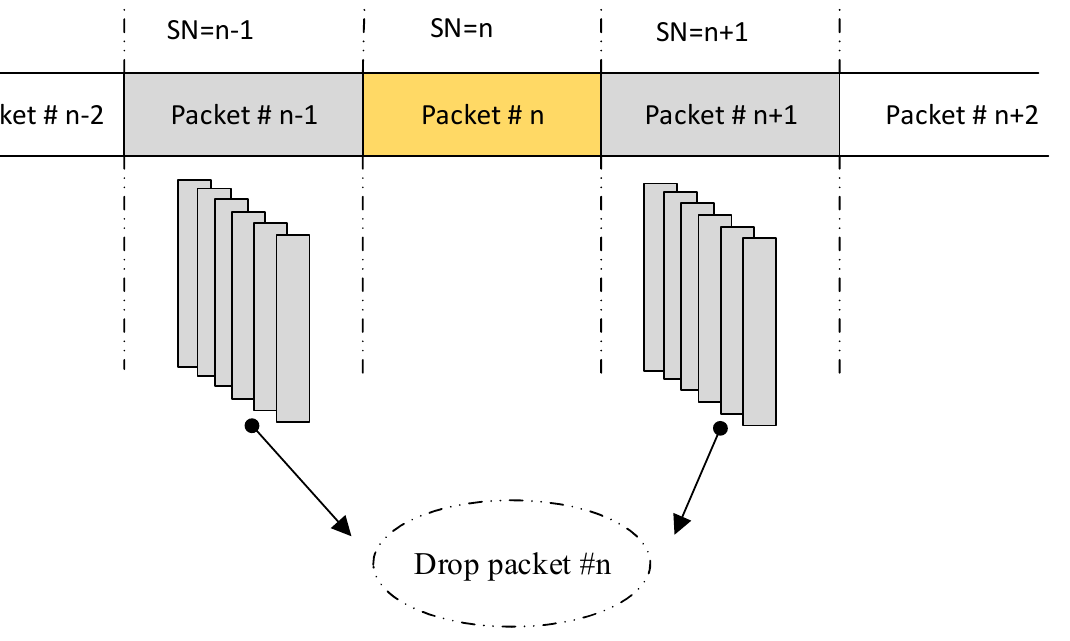
Figure 14. An example of an undersampling case.